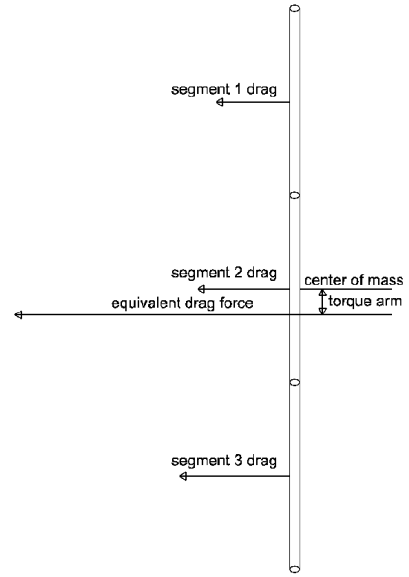
Figure 2. The diagram of forces resulting in tether